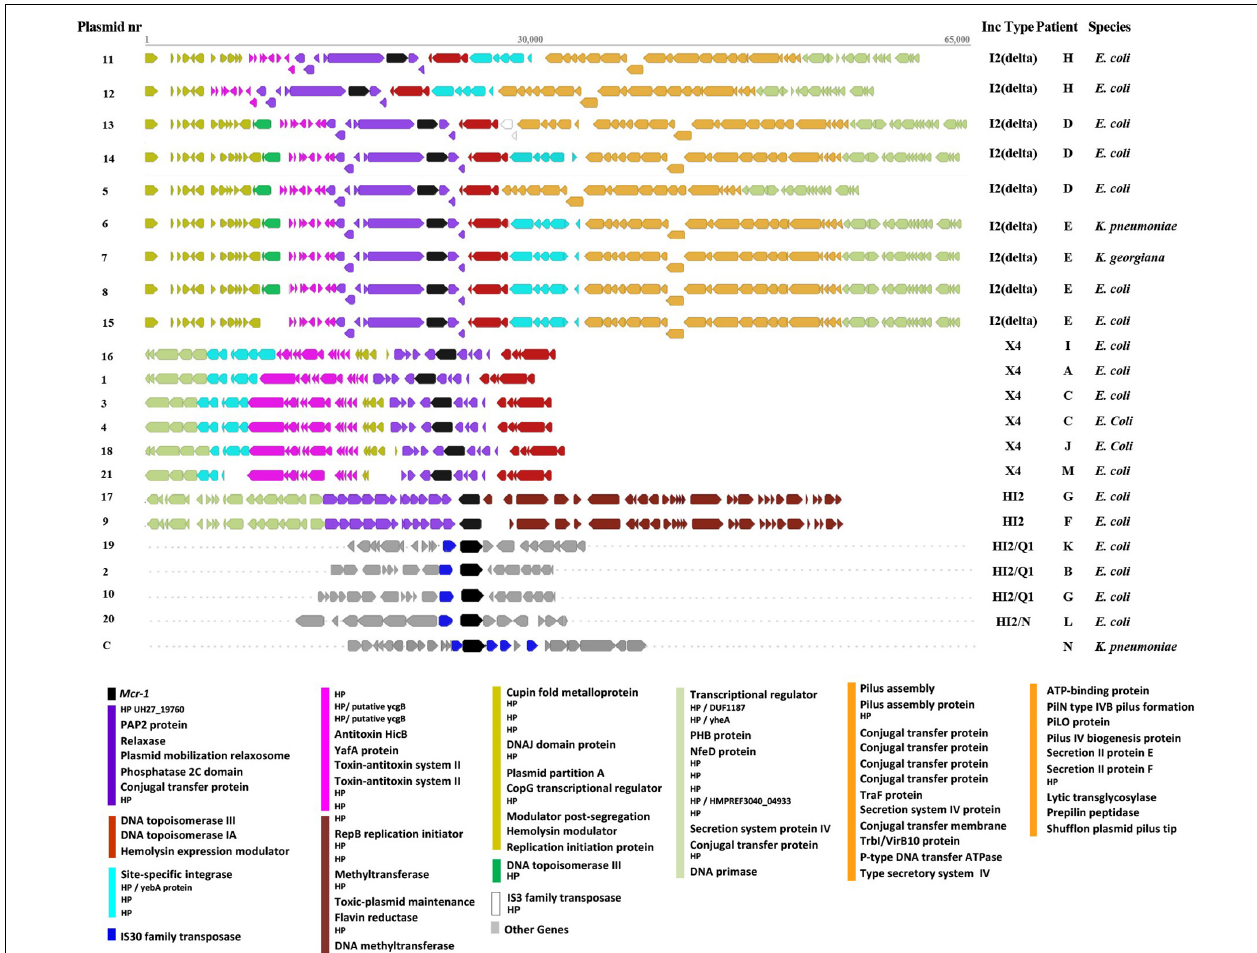
FIGURE 1 | Graphical representation of genomic regions in plasmids containing the mcr-1 gene and annotated using Prokka. Conserved regions as defined by Mauve alignment are represented by different colors. Each arrow represents a gene and dots indicate that the presented region is part of a much larger plasmid/chromosome. HP , hypothetical protein encoding